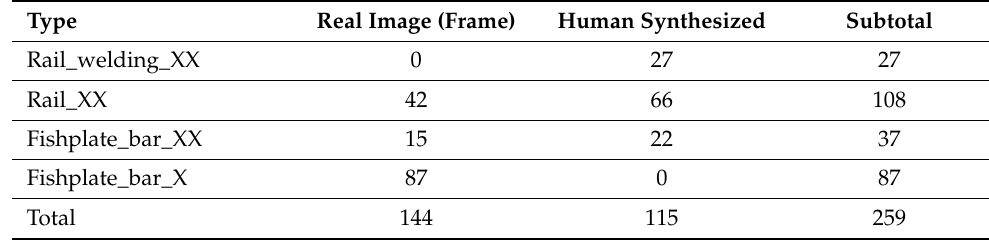
Table 6. The augmented side-view